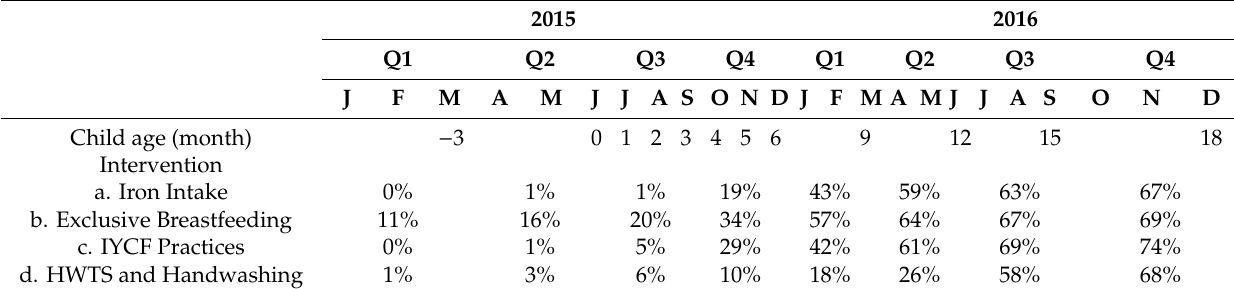
Table 1. Percent coverage of the intervention throughout study period from third trimester pregnancy until 18 month postdelivery (summarized